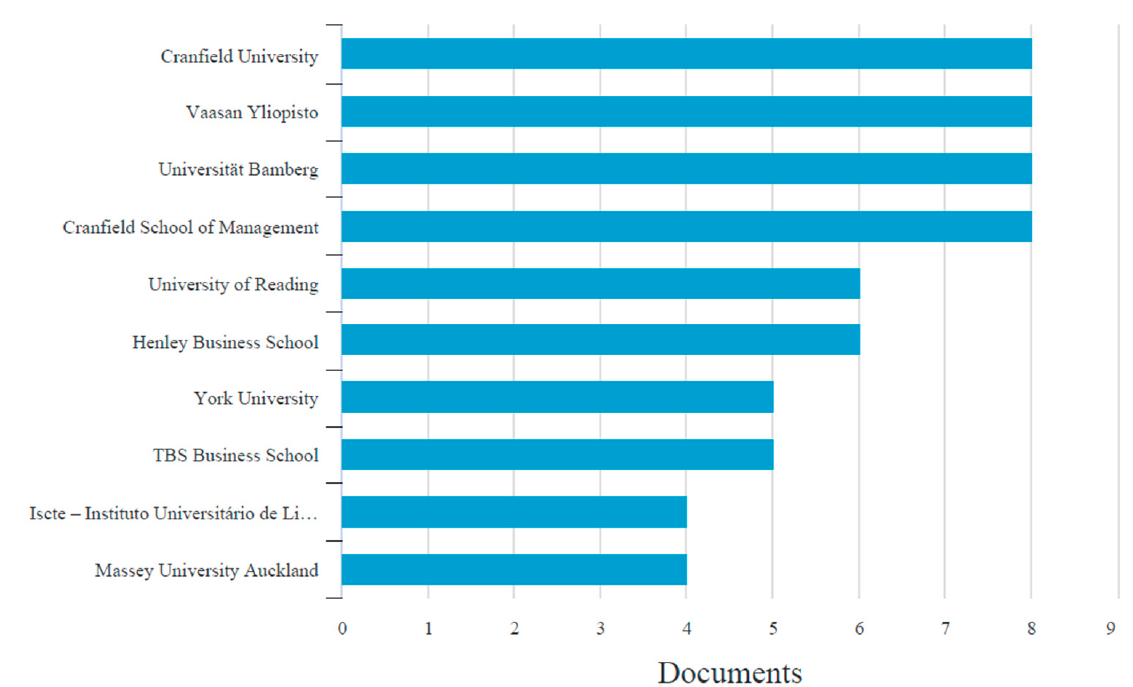
Figure 12. Self-initiated expatriation documents by affiliation. Source: Data obtained from Scopus (August 2022).